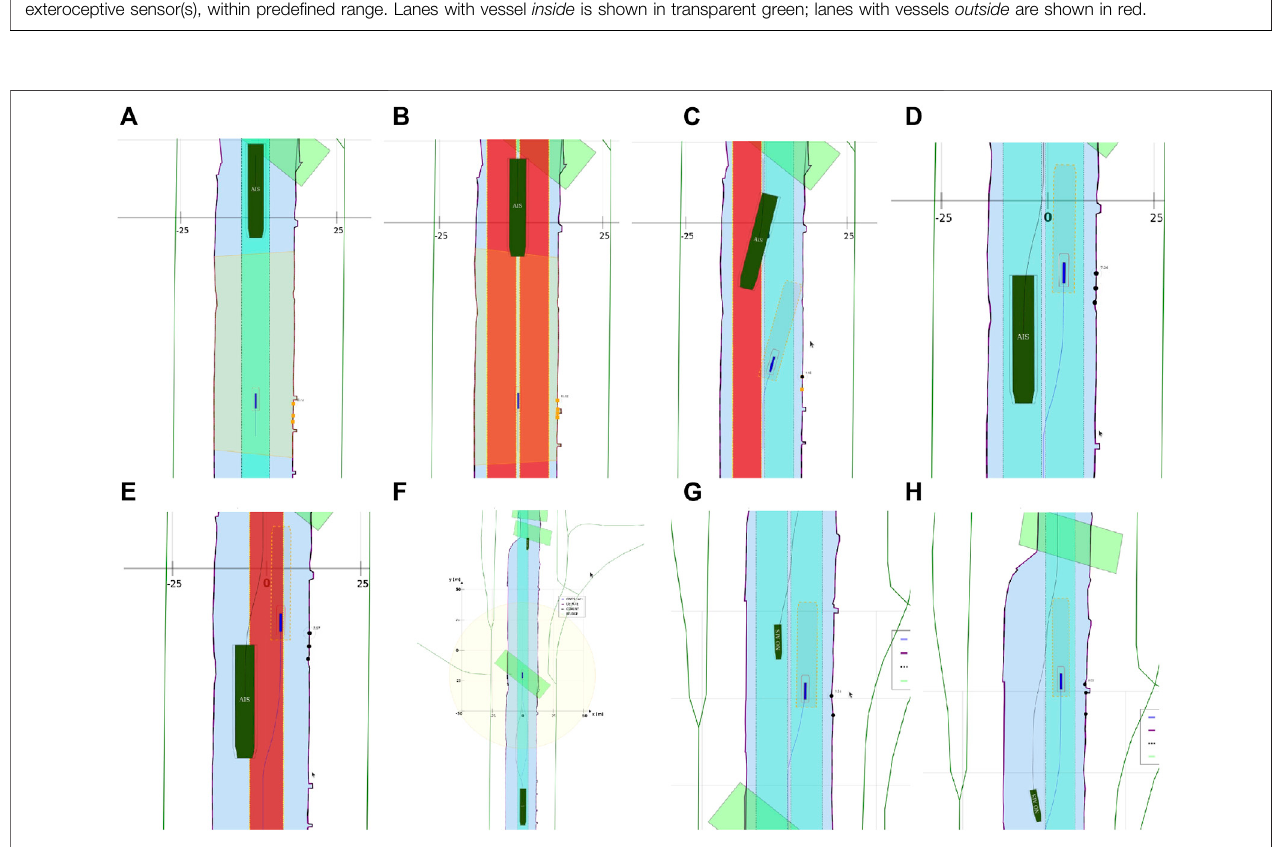
FIGURE 14 | Combination of situations and relations of previous experiments, with additional sensor subsystem relations.